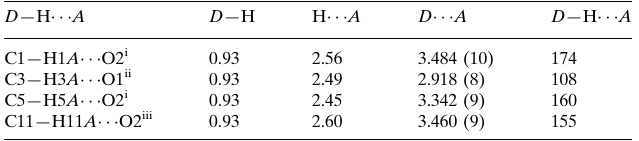
Hydrogen-bond geometry (A˚ , (cid:2)